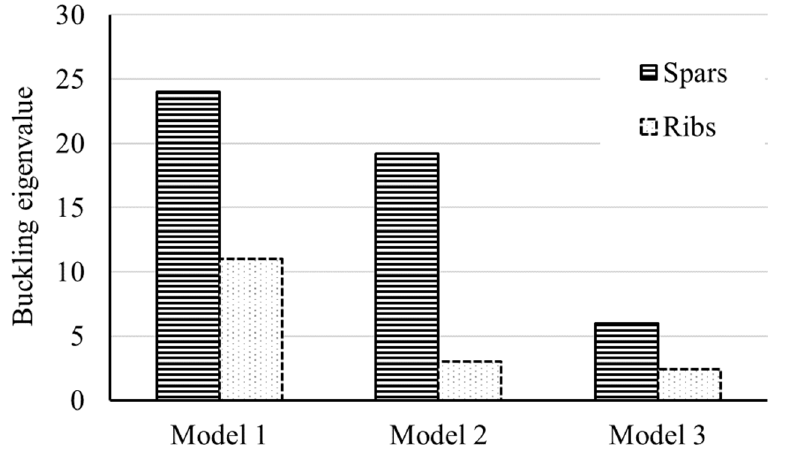
Figure 9. Comparison of buckling eigenvalue between multi-spar and multi-rib configurations.